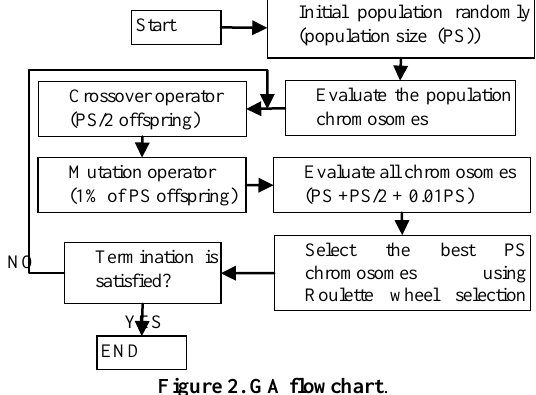
Figure 2. GA flowchart .